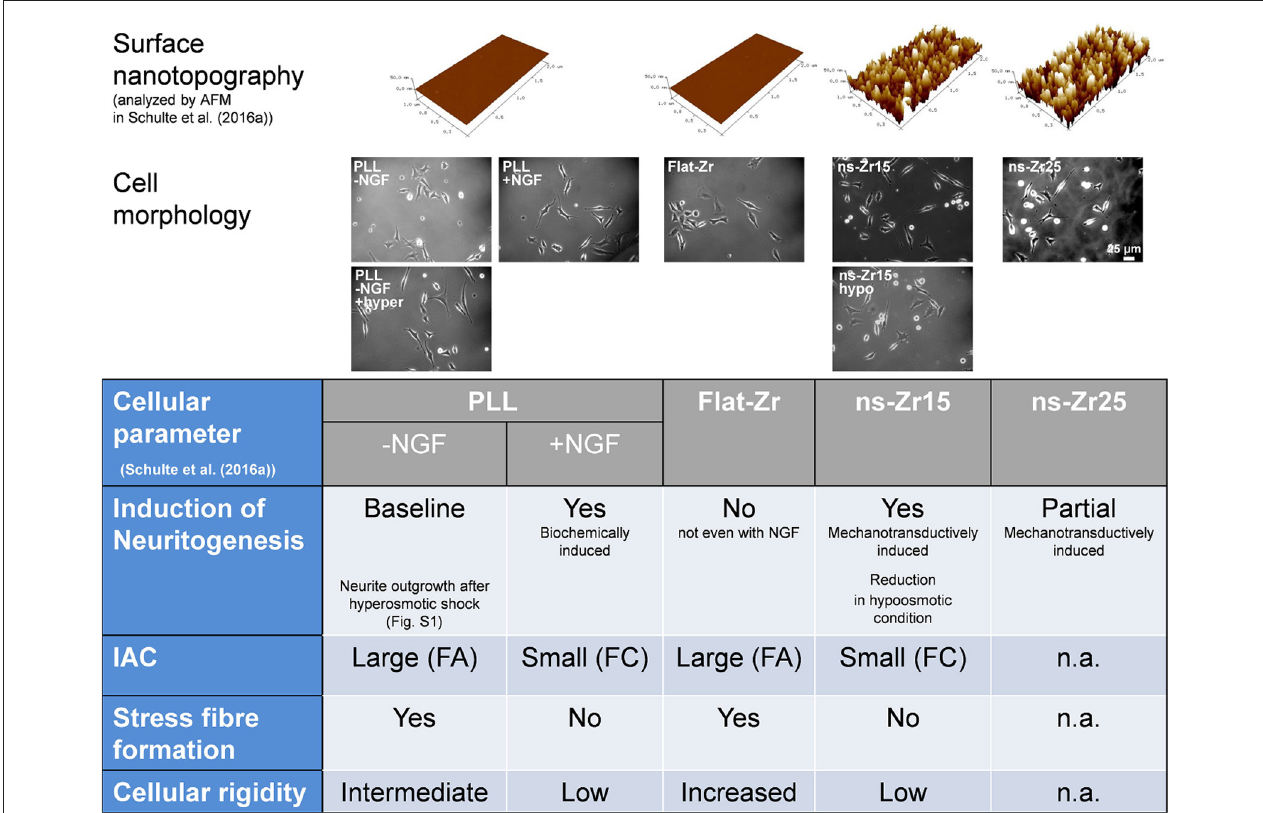
FIGURE 1 | Representations of the cell morphology in the different conditions and a summary of the results presented in a previous publication (Schulte et al., 2016a). The figure summarizes the results of our previous publication (Schulte et al., 2016a) which provided the basis for the selection of the experimental conditions of the extended phosphoproteomic analyses of this work. In the upper row representations of the surface nanotopographies are displayed which were also used in this work (PLL-coated glass, flat-Zr, ns-Zr15, and ns-Zr25). Underneath example photos demonstrate the morphology of PC12 cells in the indicated conditions. In the table the impact of these different conditions on examined cellular parameter are recapitulated (FA, focal adhesions; FC, focal complexes; IAC, integrin adhesion complex; n.a., not analyzed).